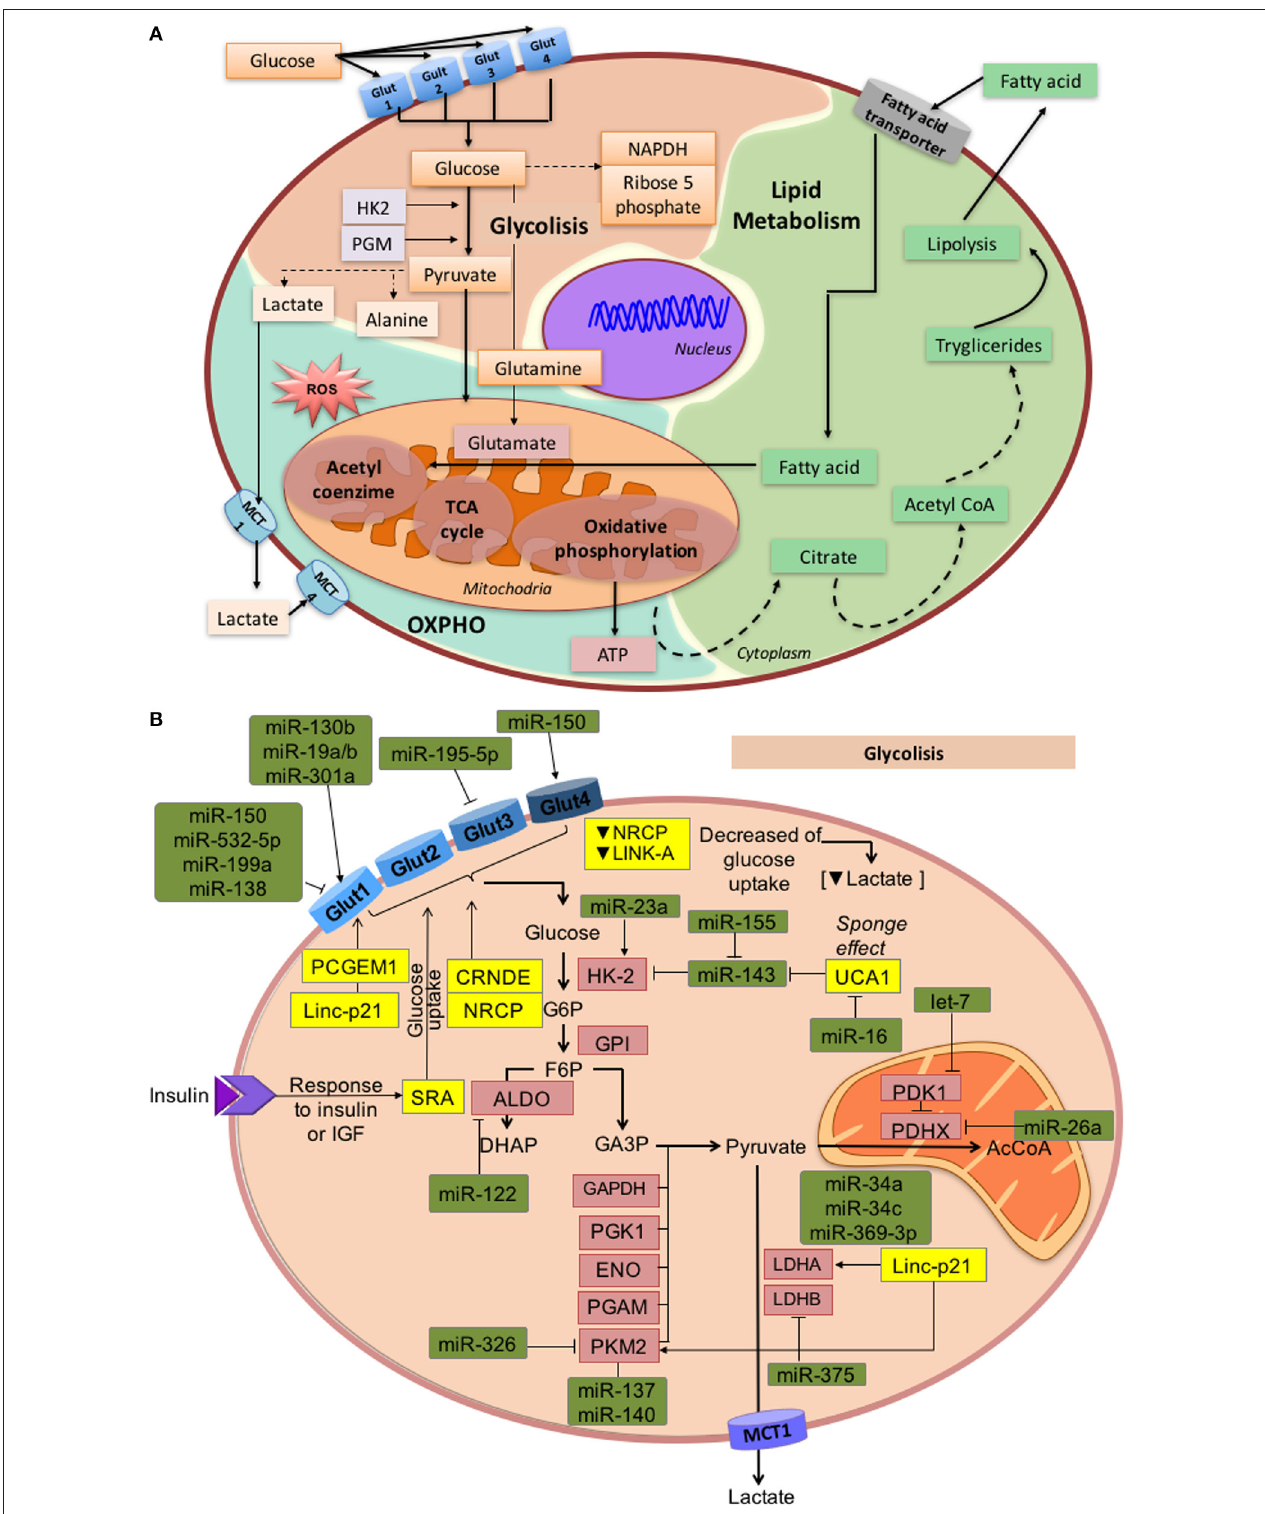
FIGURE 2 | Overview of glycolysis, OXPHO, and lipid metabolism. (A) This figure describes the connections between metabolic sub-products that take partindifferentmetabolicprocess,aswellasenzymesandsubstratesthatmaintainthenormalmetabolicenvironment.GlycolysisoccursinthecytosolwhenD-glucoseis